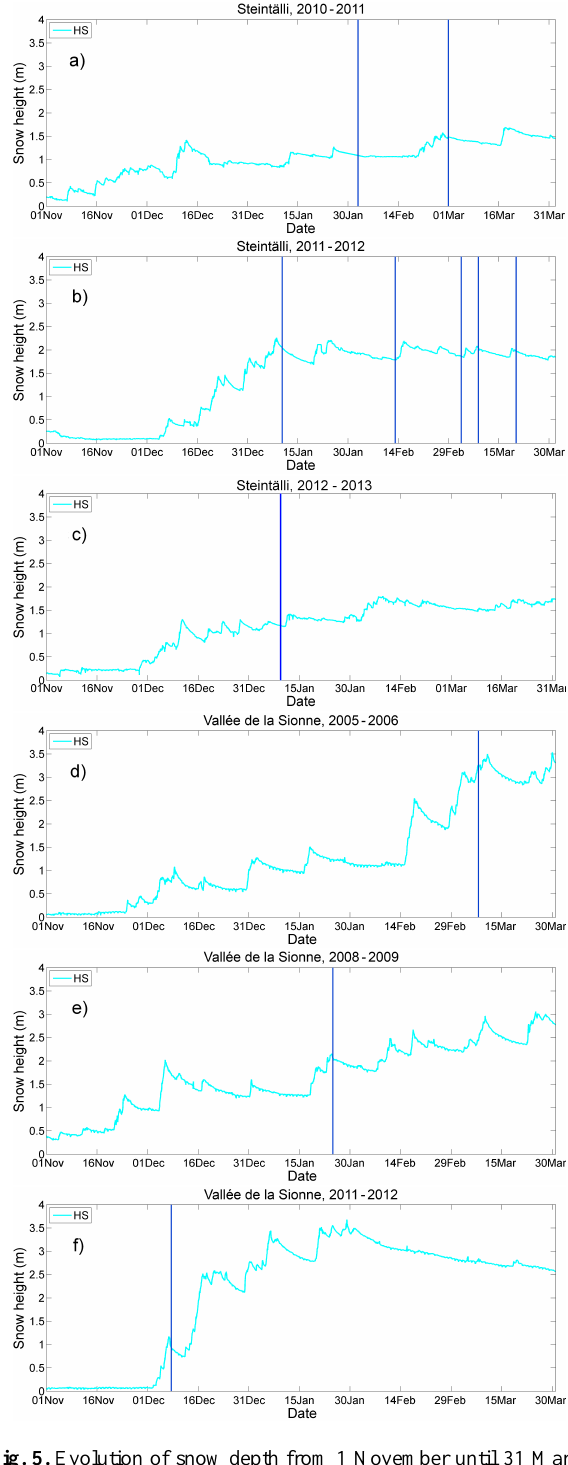
Fig. 5. Evolution of snow depth from 1 November until 31 March measured (a–c) at the weather station WAN7 in Steintälli and (d–f) Fig. 5: Evolution of snow depth from 1 November until at the weather station Donin du Jour in Vallée de la Sionne. The 31 March measured (a–c) at the weather station WAN7 in vertical blue lines correspond to the acquisition times of the laser Steint¨alli and (d–f) at the weather station Donin du Jour in scans. the Vall´ee de la Sionne. The vertical blue lines correspond to the acquisition times of the laser scans.